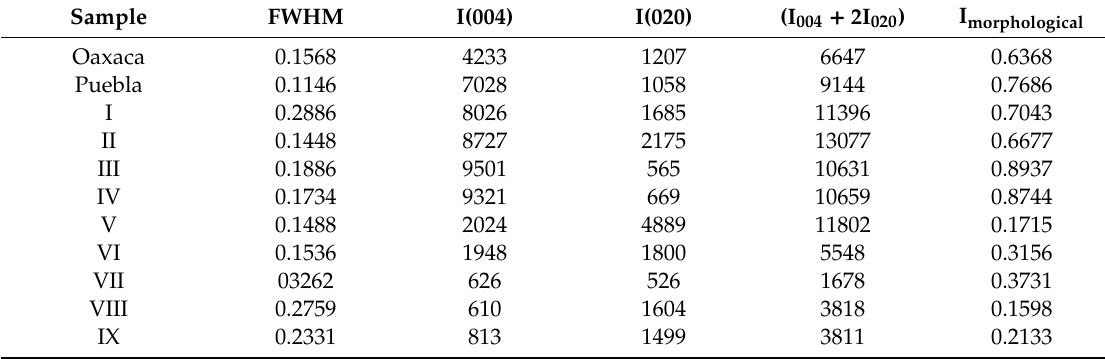
Table 3. Morphological index [26], of natural Mexican talc from Oaxaca and Puebla ore deposits and cosmetic talc of high and low